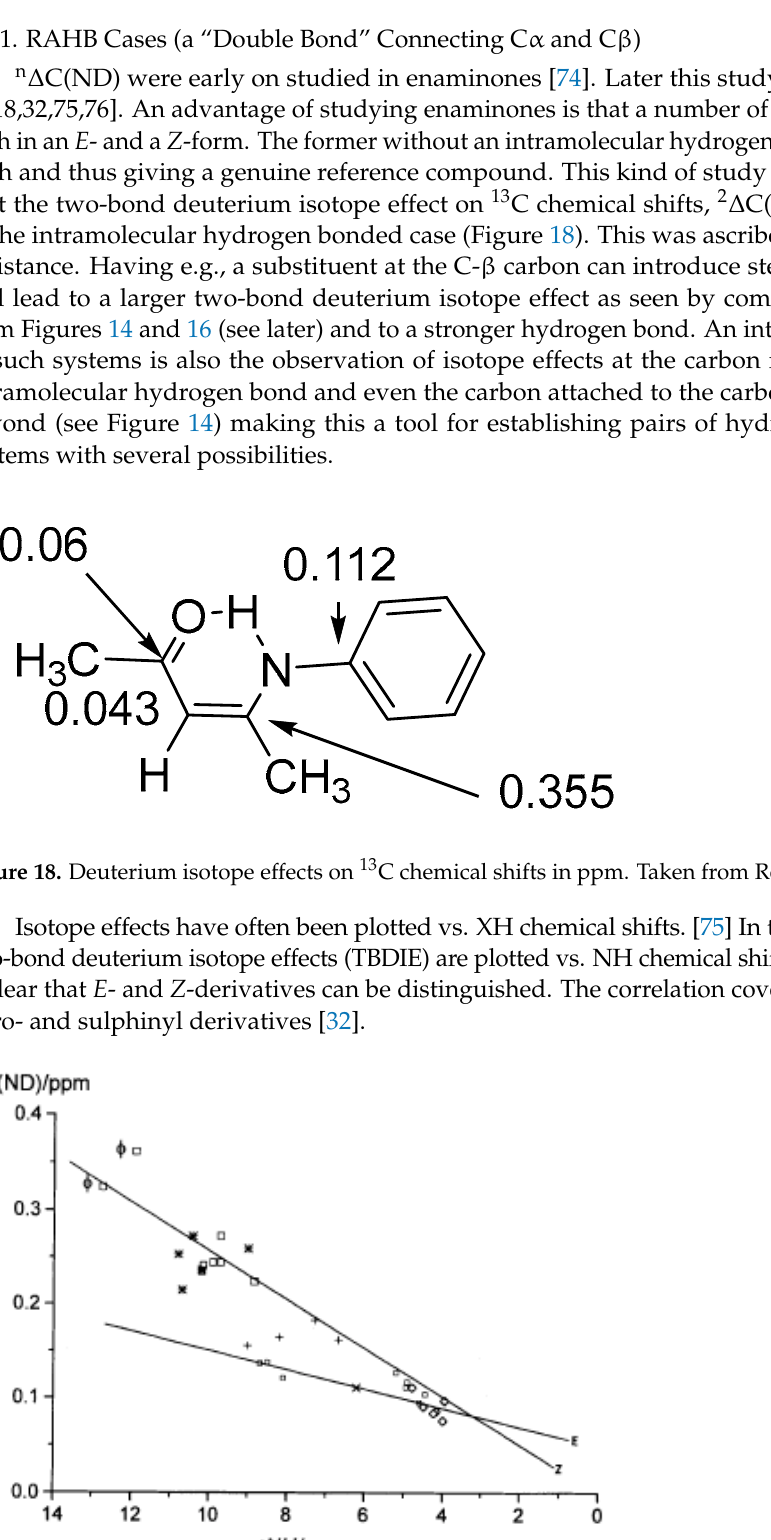
Figure 19. Plot of two ‐ bond deuterium isotope effects on 13 C chemical shifts vs. NH chemical shifts for enamines. Open squares ( Z ) ‐ enaminones, closed squares ( E ) ‐ enaminones, + enamino esters, * ( Z ) ‐ nitroenamines, crosses ( Z ) ‐ sulphinylenamines and diamonds ( E ) ‐ sulphinylenamines, φ indi ‐ cates N ‐ phenyl groups. Taken from [32] with permission from Wiley. One ‐ bond deuterium isotope effects, 1 Δ N(D), depend strongly on hydrogen bonding (the geometry) and related to that RAHB (see Figure 20). [32]